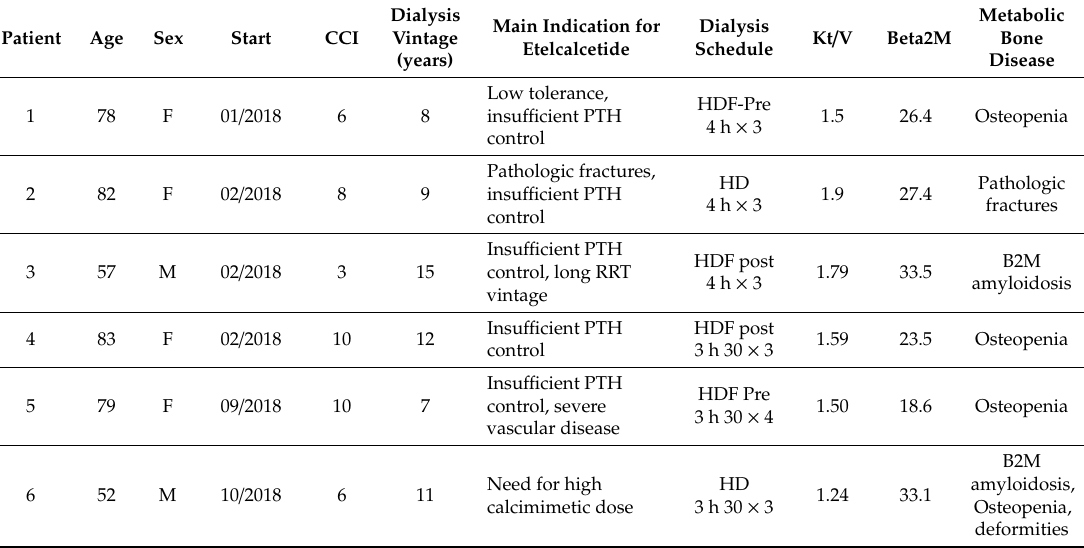
Table 1. Baseline clinical data in the selected